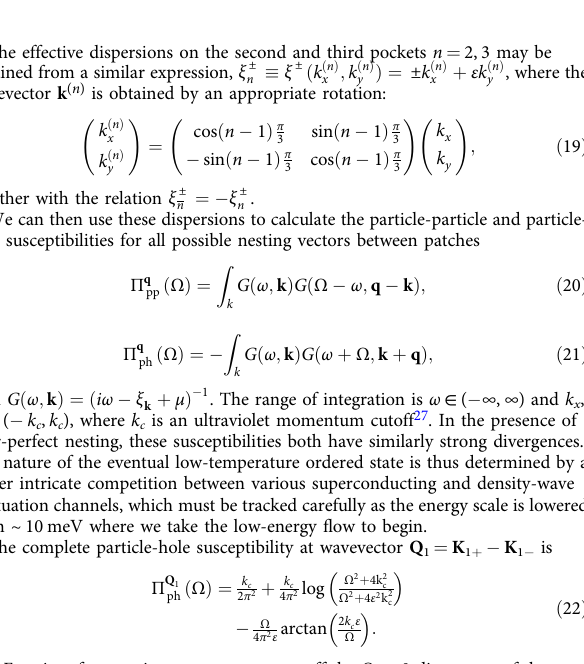
Fig. 3 The six types of two-particle interaction in our low-energy theory of monolayer 1T-VSe 2 . We illustrate these here for the four patches in group 1. g 1 and g 2 are exchange and density-density interactions between patches separated by the wavevector Q 1 , g 3 and g 4 are exchange and density-density interactions between patches with opposite momenta, and g 5 and g 6 are the two possible exchange interactions that involve all